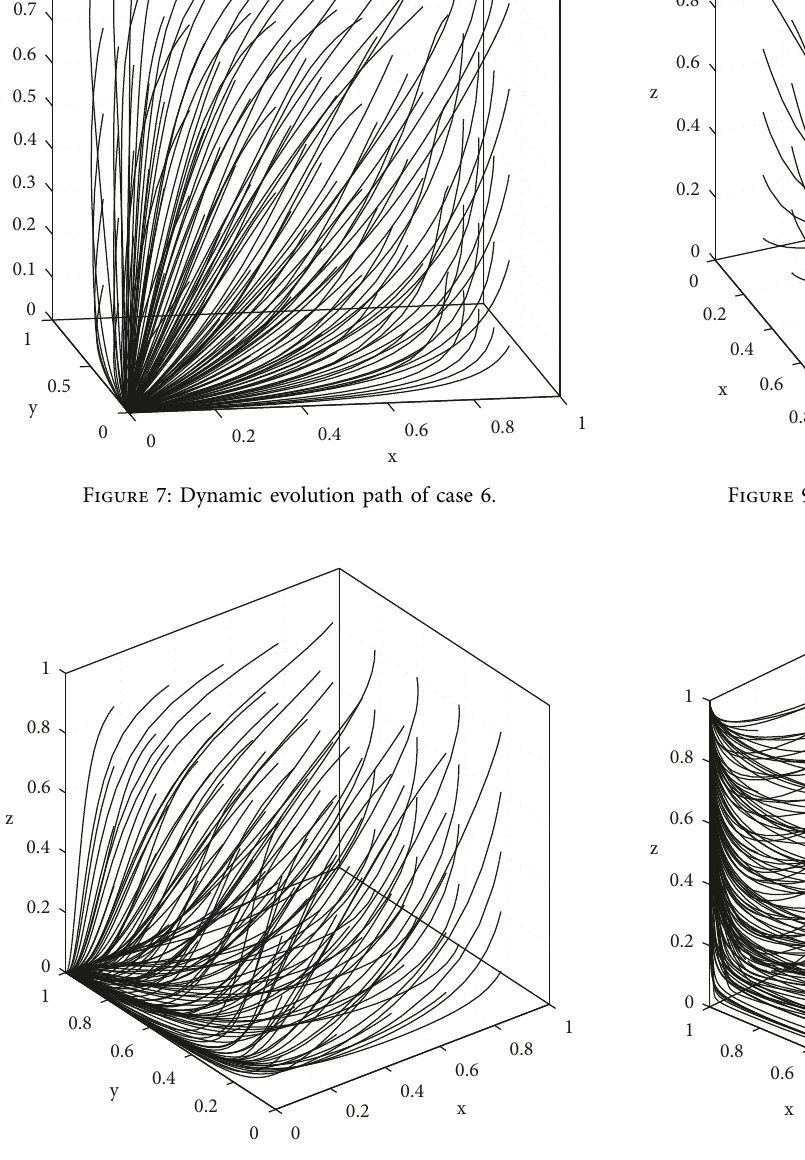
Figure 10: Dynamic evolution path of case